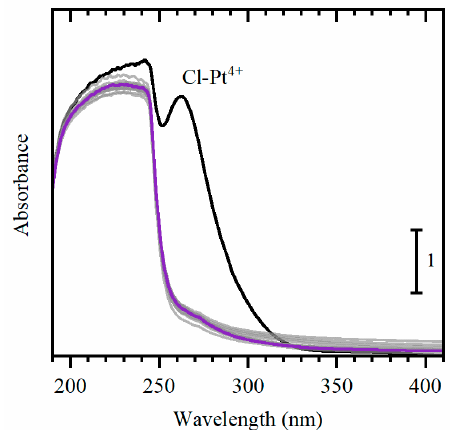
Figure 3. Evolution of UV–Vis spectra of the K 2 PtCl 6 solution during photodeposition of Pt on TiO 2 . The spectra before and after 90 min UV irradiation are shown in black and violet, respectively; intermediate data are shown in light grey.